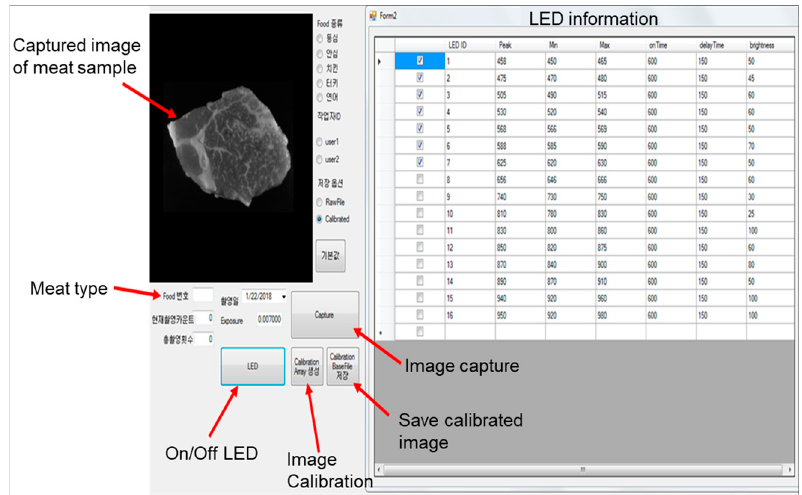
Figure 2. Custom-built software for meat-image acquisition.